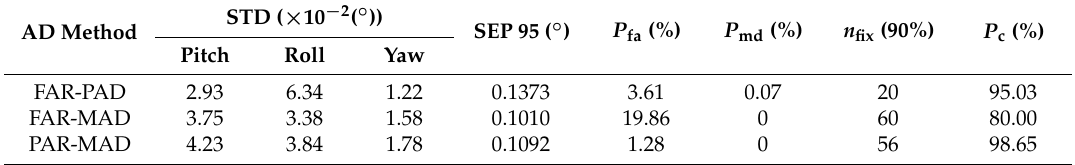
Table 2. Statistical results of ambiguity resolution and AD for different methods in static experiment.